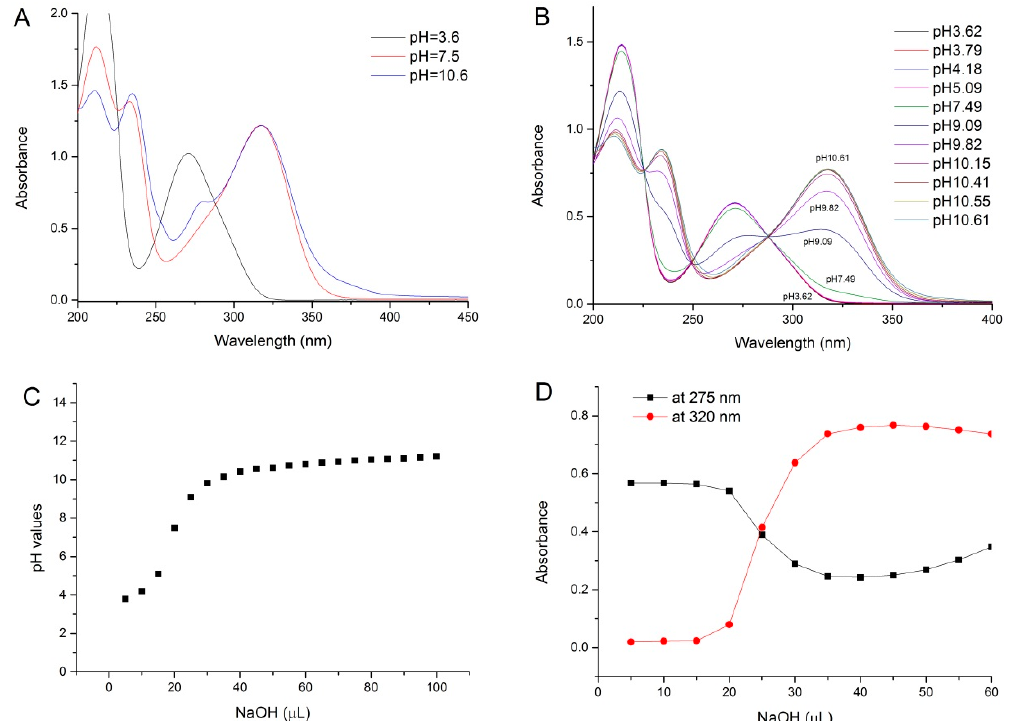
Figure 6. ( A ) pH of free and deprotonated methyl gallate; ( B ) evolution with pH of the UV ‐ vis spectra of methyl gallate; ( C ) pH changes of methyl gallate solution with the increment of NaOH; ( D ) absorbance changes of methyl gallate solution at 320 nm and 275 nm with the increment of NaOH.